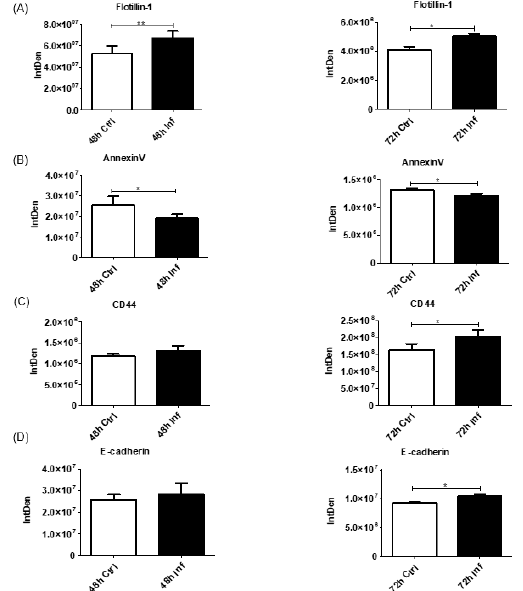
Figure 4. The effect of CCoV infection on EV biogenesis and membrane proteins. Graphs showing densitometric analysis of dot blot of ( A ) flotillin-1 at 48 h and 72 h (Supplementary Figure S2B), ( B ) biogenesis protein annexin-V at 48 h and 72 h (Supplementary Figure S2C), ( C ) multifunctional transmembrane receptor CD44 at 48 h and 72 h (Supplementary Figure S2D), and ( D ) canine-specific adhesion molecule E-cadherin at 48 h and 72 h (Supplementary Figure S2E), in isolated control and infection EVs. Statistical analysis of obtained data points was performed using one-way ANOVA with Tukey post hoc analysis. Statistical significance is indicated by the mean ± SD and is defined as p ≤ 0.05 (*) and p ≤ 0.01